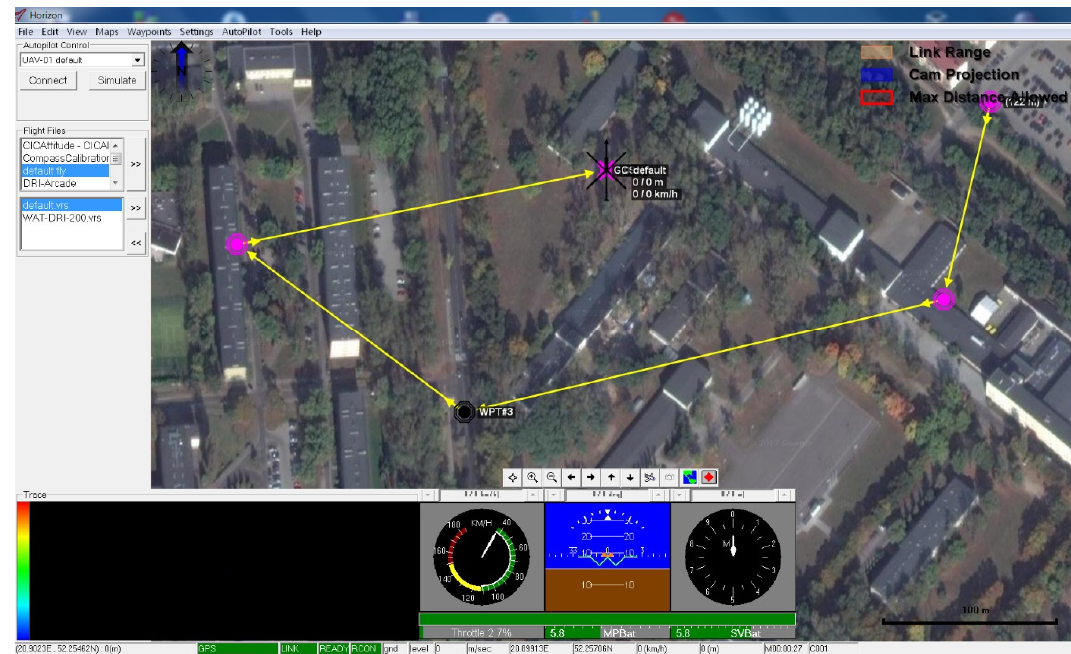
Figure 4. Horizon software interface used in flight control.